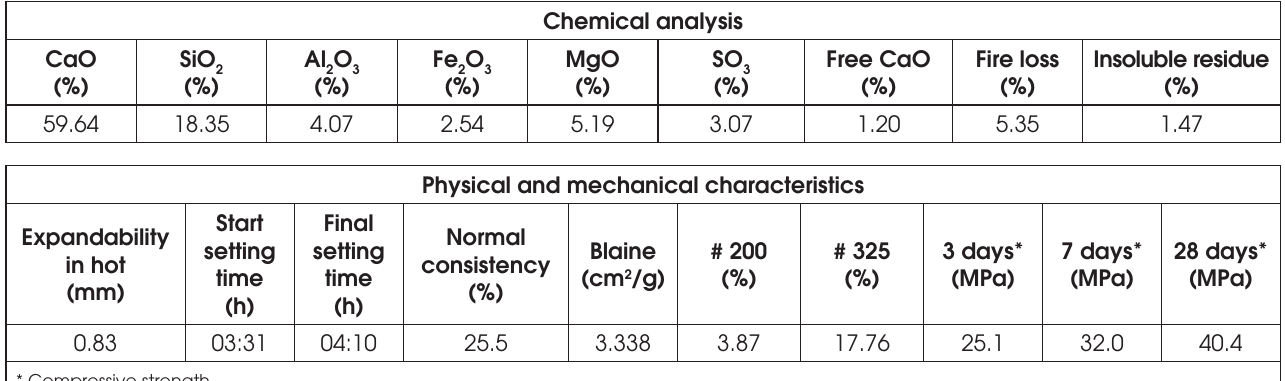
Physical, mechanical and chemical characteristics of cement CP II F –